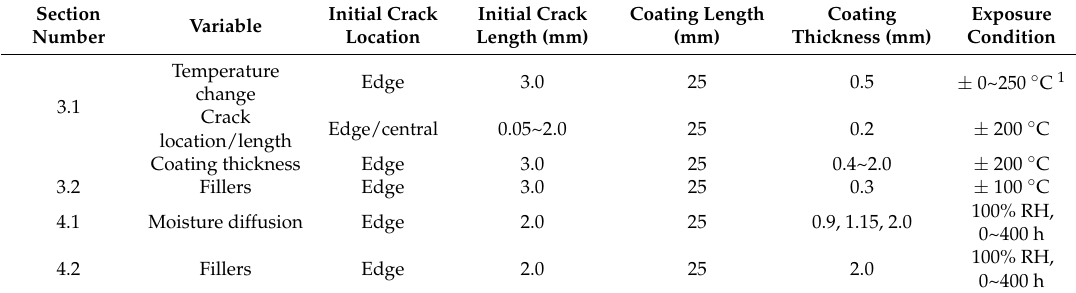
Table 1. Parameters of the geometries of pre-crack/coating and boundary conditions.